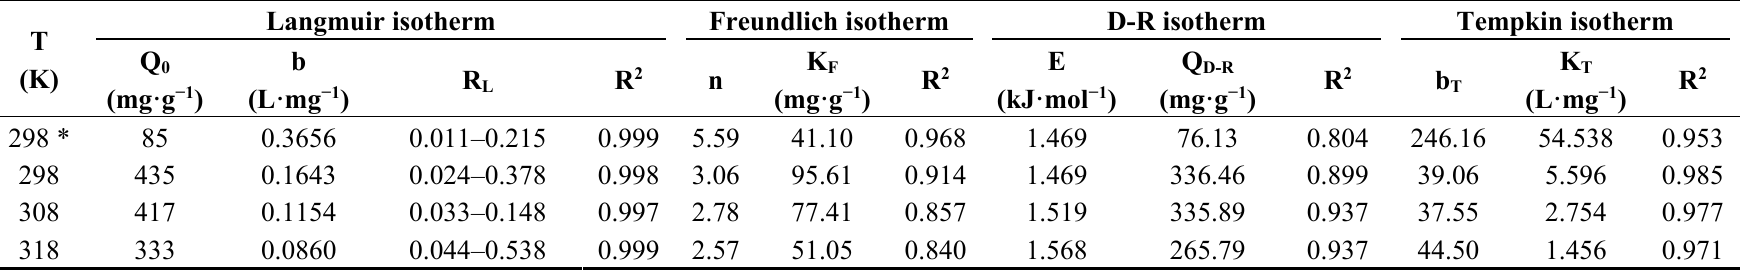
Table 2. Langmuir, Freundlich, Dubinin–Radushkevich (D-R) and Tempkin adsorption isotherms for Orange II adsorption onto Fe(BTC) and activated carbon at different